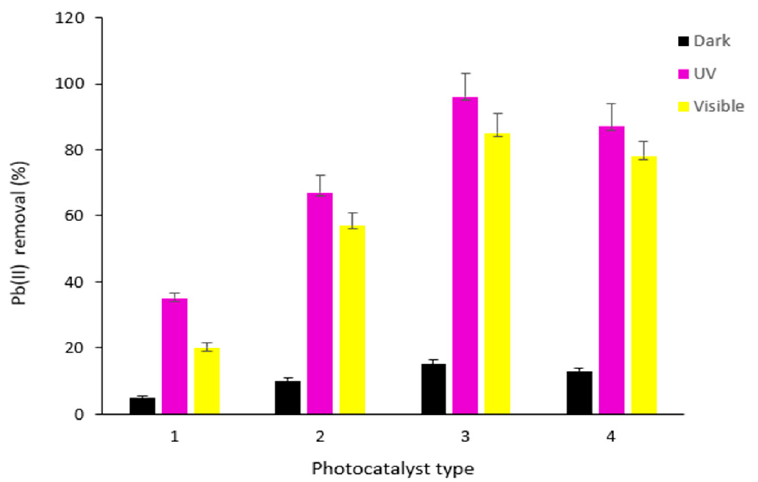
Figure 5. The effectiveness of the Pb(II) photo-oxidation over ( 1 ) TiO 2 , ( 2 ) TiO 2 –N (5), ( 3 ) TiO 2 –N (10) and ( 4 ) TiO 2 –N (15); under dark condition; and UV and visible light irradiation (photocatalyst weigh = 15 mg, volume of Pb(II) solution = 25 mL, Pb(II) concentration = 15 mg/L, reaction time = 30 min and solution pH =